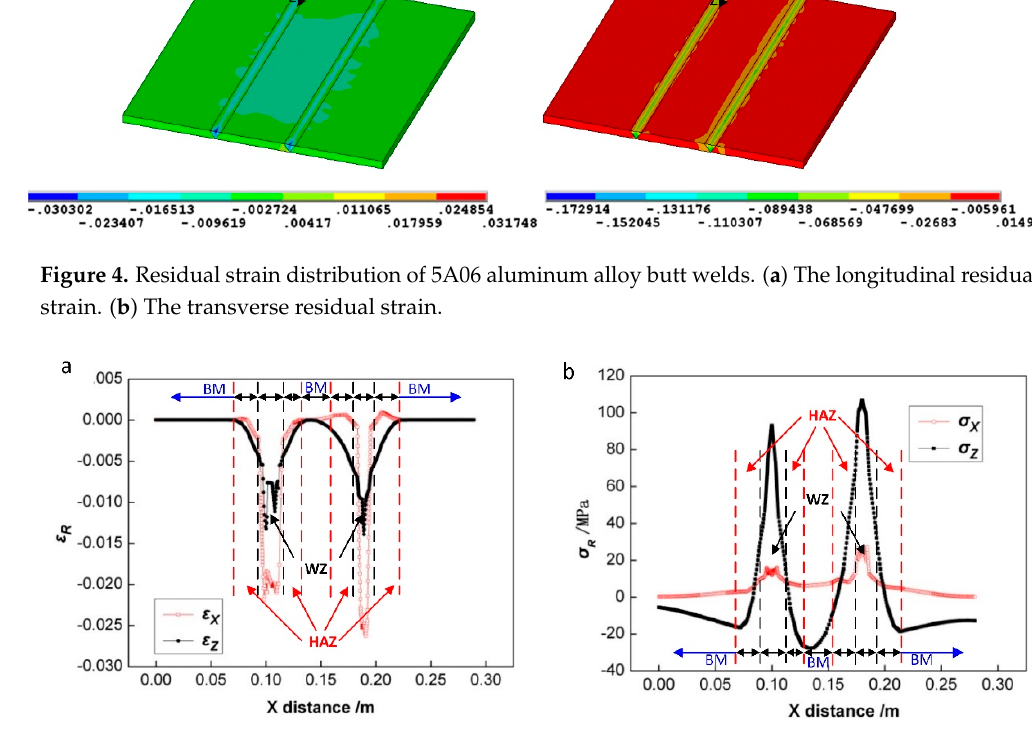
Figure 5. Residual stress and strain distribution of A ‐ A path on butt welds. ( a ) Residual strain ε R . ( b ) Residual stress σ R . (BM ‐ base material, HAZ ‐ Heat Affected Zone, WZ ‐ welded zone).